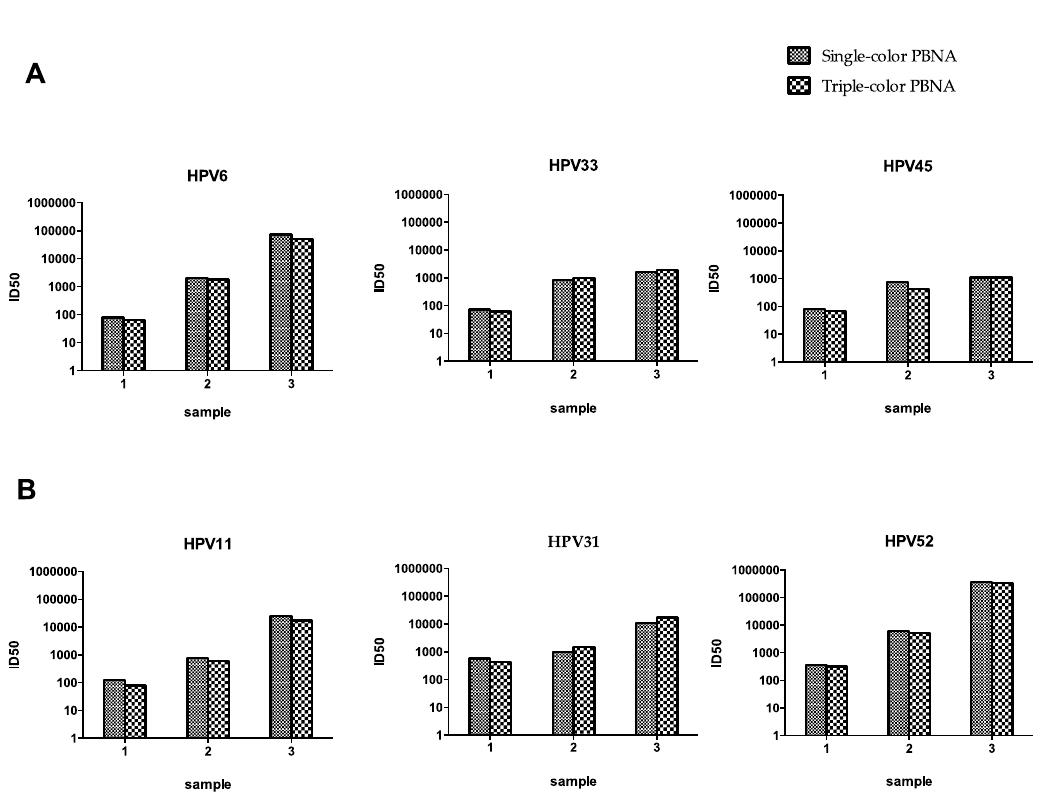
Figure 7. Comparison of the single- and triple-color PBNA for HPV6-33-45 and HPV11-31-52 PBNAs. ( A ) Comparison of the single- and triple-color PBNA for HPV6-33-45; ( B ) Comparison of the single- and triple-color PBNA for HPV11-31-52. Three serum samples from mice immunized with different amounts of the nonavalent vaccines were tested using single-color and triple-color PBNAs, respectively.